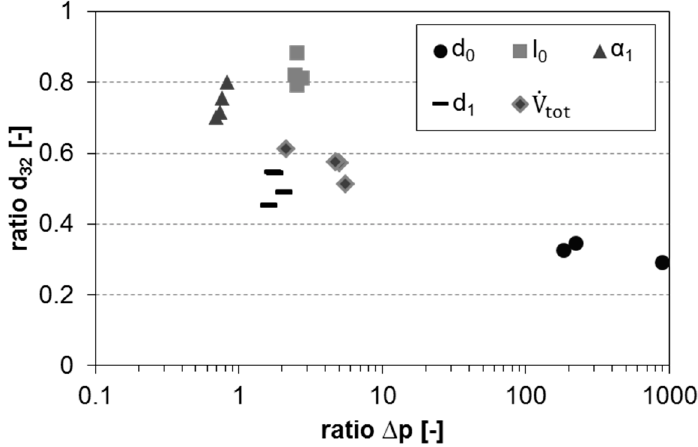
Figure 16. Diameter ratio for different pressure drop ratios indicating bubble breakup efficacy.